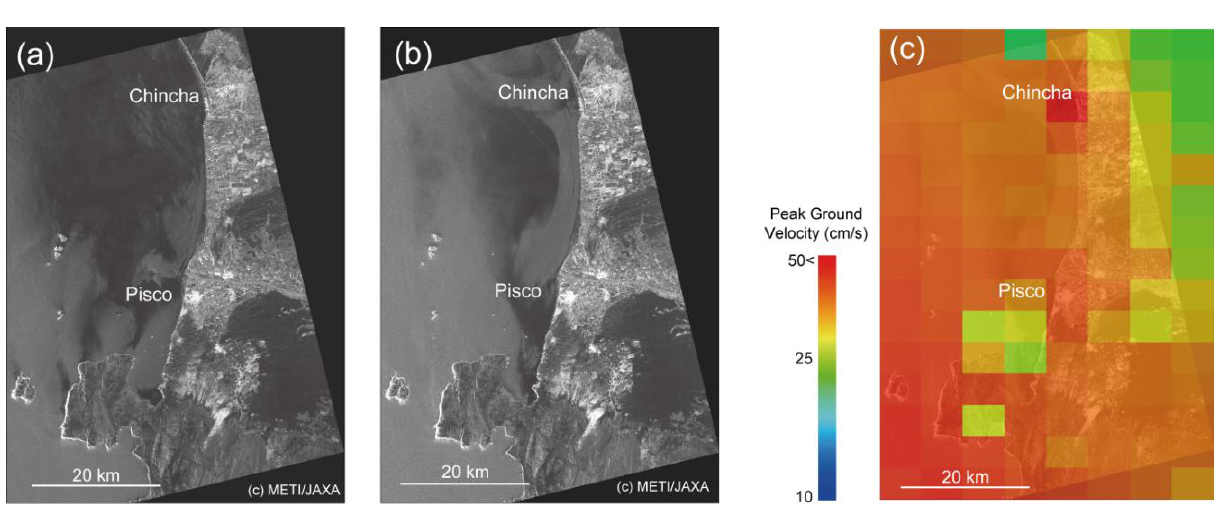
Figure 12. ALOS/PALSAR image before and after the 2007 Peru earthquake, and strong motion distribution. (a) Image taken July 12, 2007. (b) Image taken August 27, 2007. (c) PGV distribution estimated by USGS overlaid with ALOS/PALSAR image.